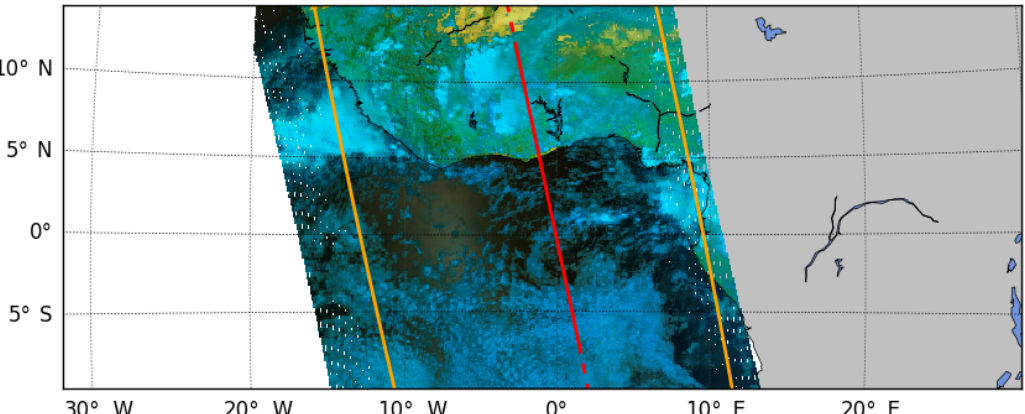
Figure 15. Study area AFR (Africa). As Fig. 9, but on 24 October 2009, 13:45LST.